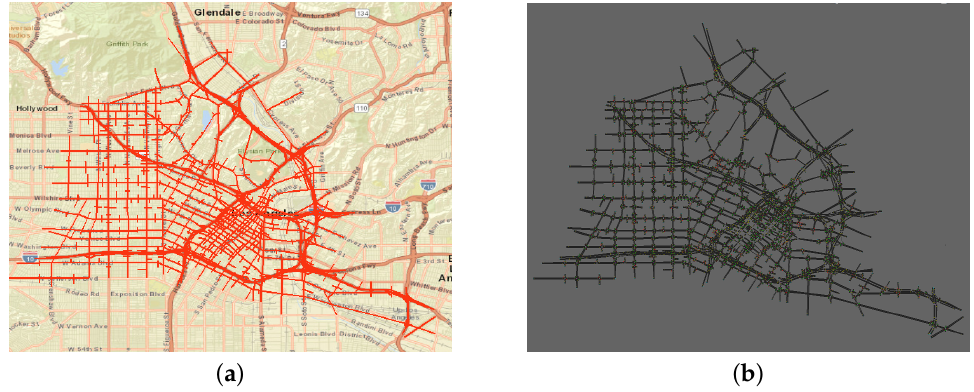
Figure 7. Downtown Los Angeles network. ( a ) LA, Google maps. ( b ) LA, INTEGRATION.